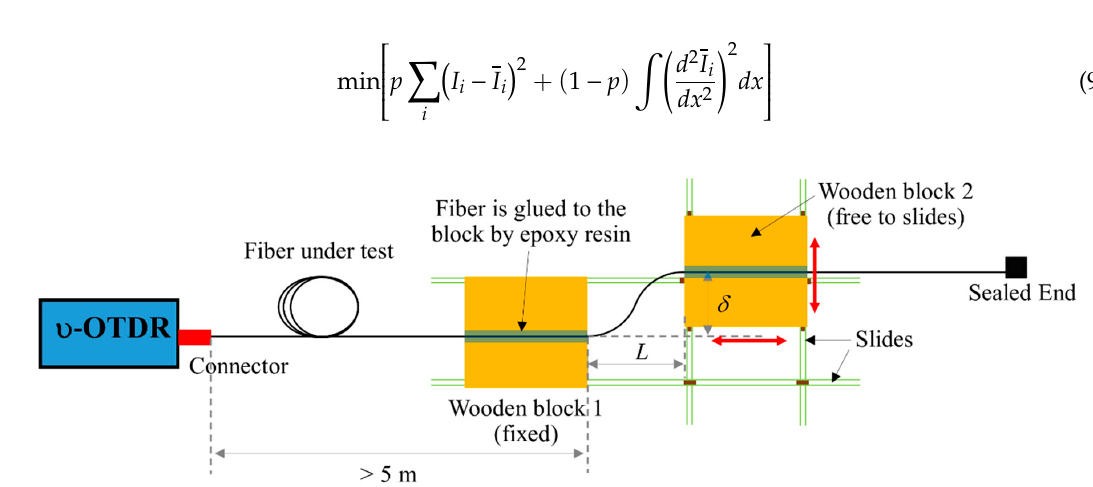
Figure 4. Shear test set-up.